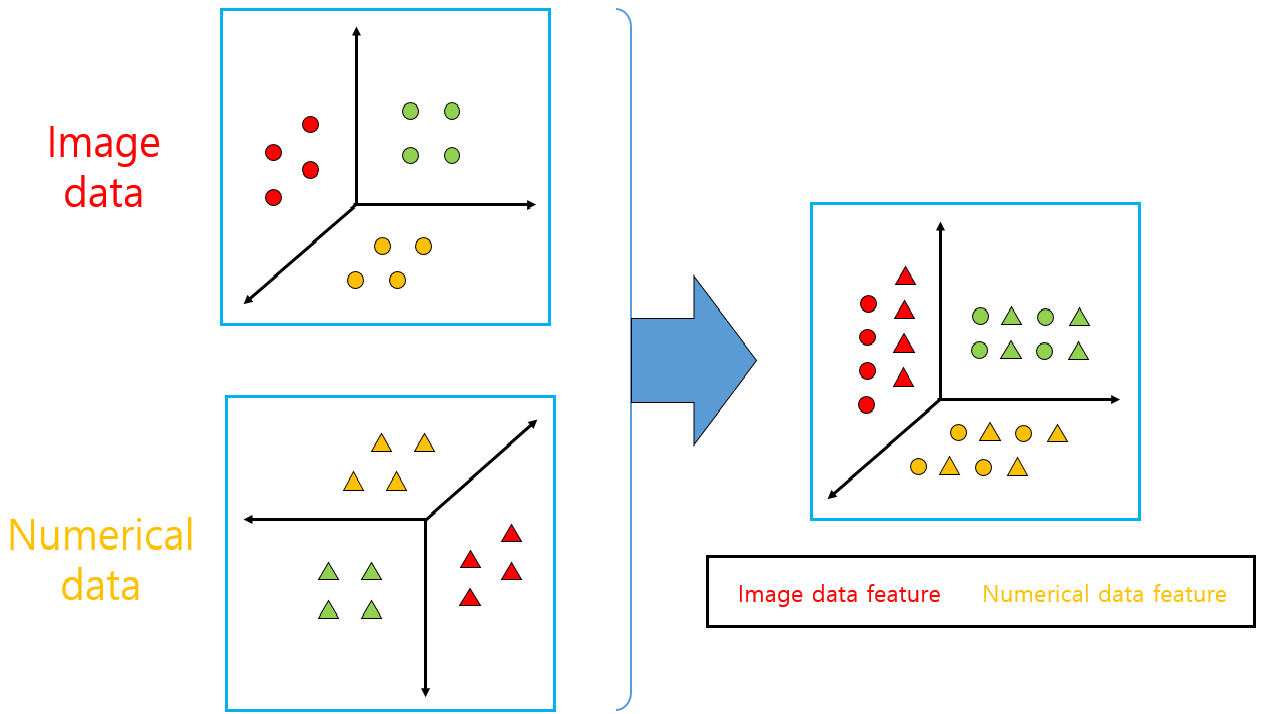
Figure 6. Integration of data dimensions: embedding data of different characteristics (image and numerical data), extracting them into data with identical characteristics, and projecting them into a shared feature space.